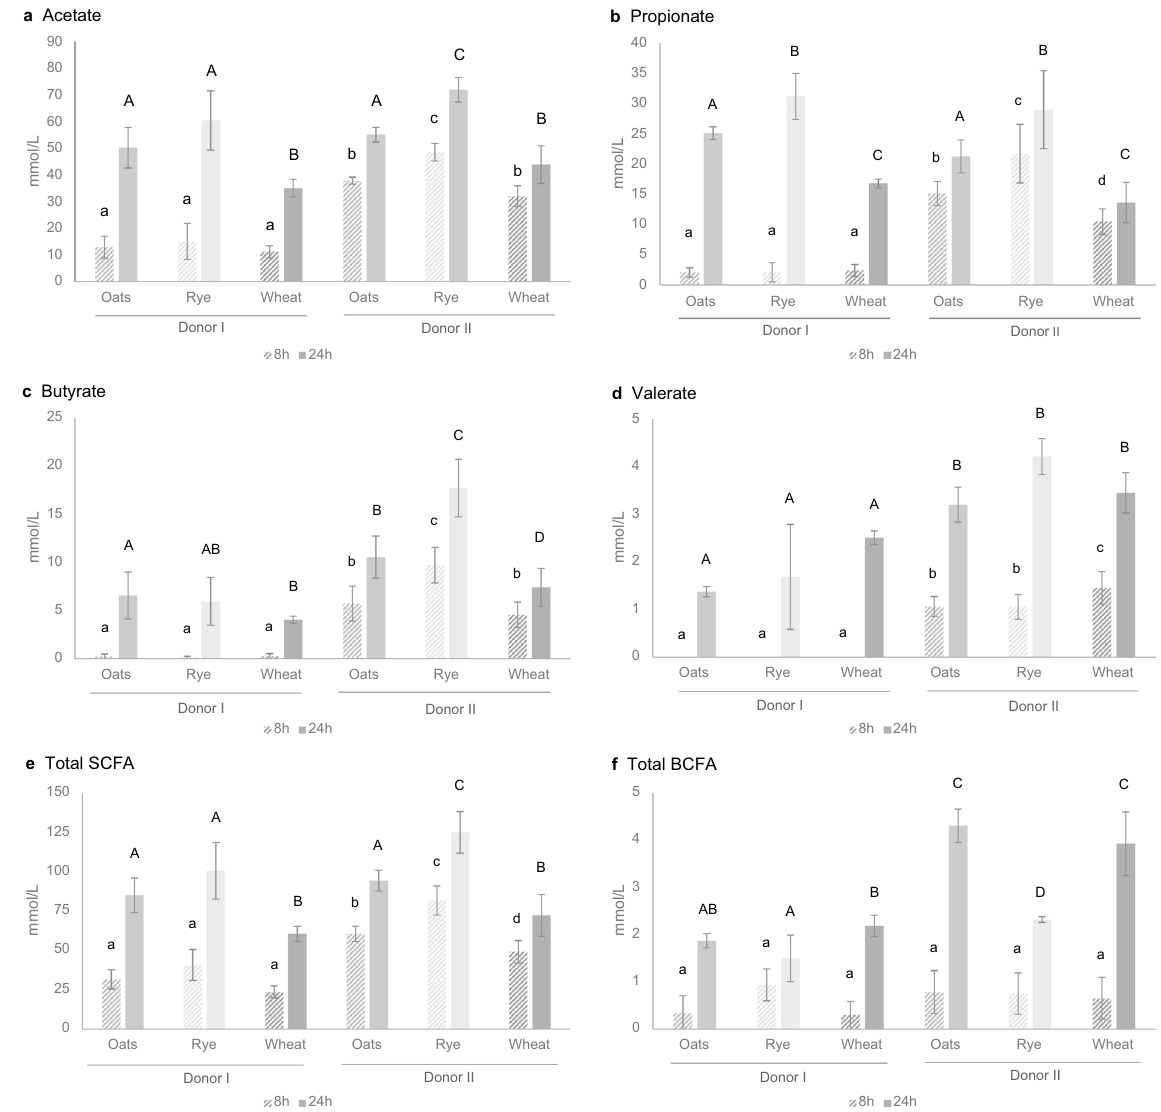
Figure 3. ( a – e ) Short-chain fatty acid and ( f ) branched-chain fatty acid concentrations after 8 h and 24 h of fermentation (mean of n = 4 replicates, error bars indicate s.d.). Different letters above bars indicate statistically significant differences in pairwise comparisons for each substrate-donor combination (lowercase 8 h, and uppercase 24 h, p < 0.05). Oats, rye and wheat indicate samples with fermentation substrates ( BCFA branched- chain fatty acids, SCFA short-chain fatty